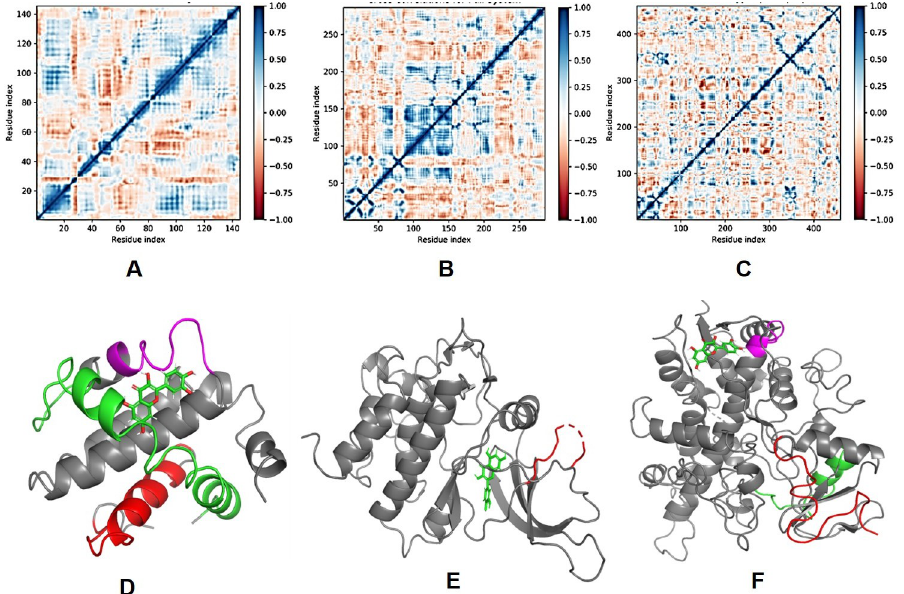
Fig 6. Dynamic Cross Correlation matrix (DCCM) of (A) BCL-2, (B) JAK2 and (C) Cyp2E1 and correlated amino acids conformed into secondary structural domains (colored) and non-correlated domains (grey) of (D) BCL-2, (E) JAK2 and (F) Cyp2E1 proteins bound with quercetin